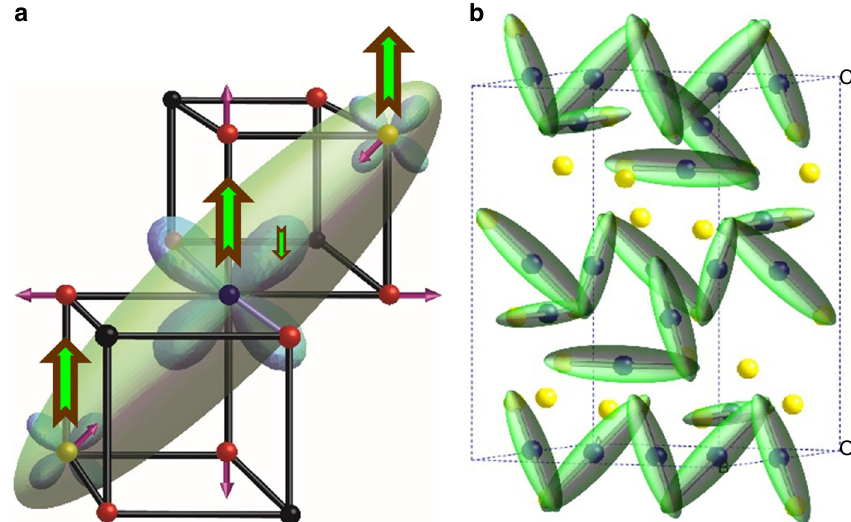
Fig. 4 Trimeron bonding driven by magnetic order in magnetite. Charge-ordered Fe 2 + /Fe 3 + states are shown as blue/yellow spheres, trimerons are green, and oxide ions are red. a A single trimeron unit consisting of three Fe sites with parallel S = 5/2 spins as shown by the brown – green arrows. Orbital order at the central Fe 2 + site localises an antiparallel spin electron in one of the t 2g orbitals, which distorts the local structure through elongation of four Fe – O bonds and shortening of the distances through weak bonding to two Fe neighbours in the same plane, as indicated by the purple arrows. The minority spin electron density is approximated by the ellipsoid shown. b Long-range order of trimerons in the monoclinic superstructure formed below the Verwey transition. Corner-sharing of trimerons results in a complex pattern of atomic displacements that has been used to model the local structure in the pair distribution